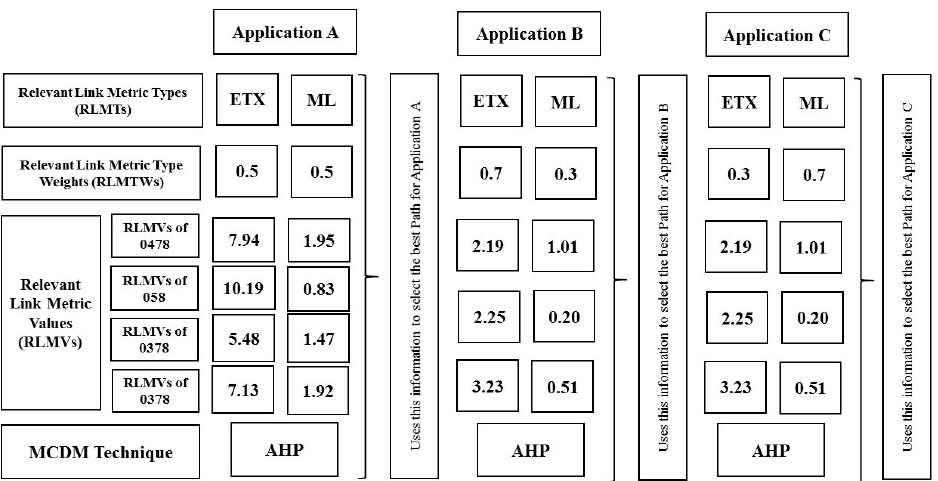
Figure 3. Example of using the multiple metrics framework for three different application traffic types.